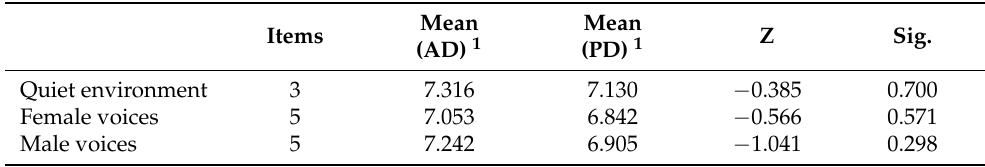
Table 5. Environmental sound evaluation comparison between PD and AD settings. Mean Mean Z Sig. Items (AD) 1 (PD) 1 Quiet environment 3 7.316 7.130 − 0.385 0.700 7.053 6.842 − 0.566